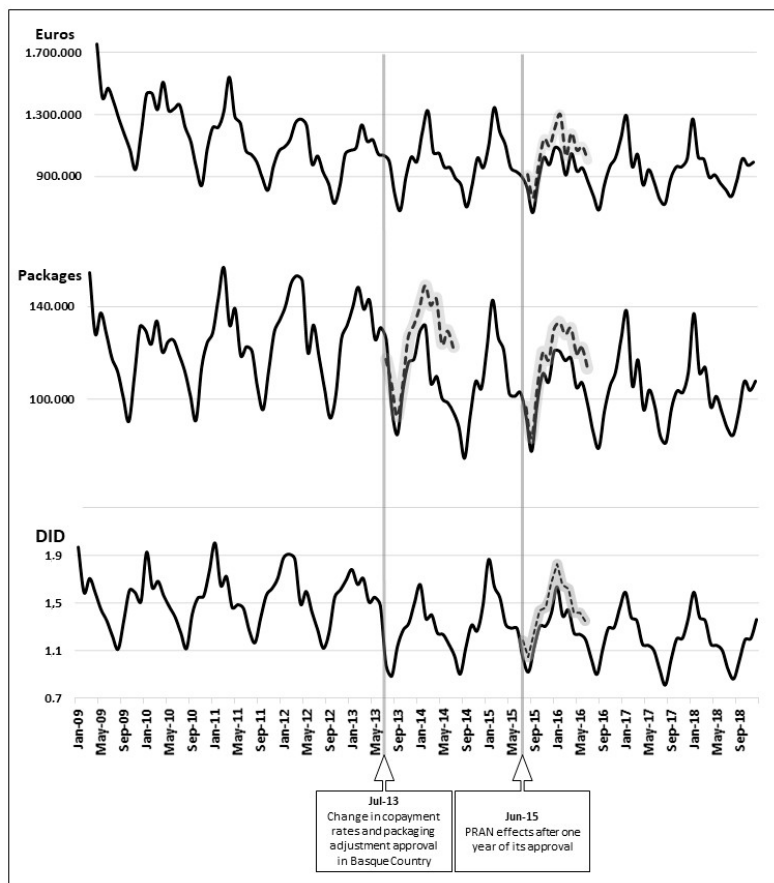
Figure A1. Time series of antibiotic dispensing ( € , packages and DID). Black line: monthly prescription values; dashed line: forecasts (80% confidence interval) obtained in counterfactual analysis. Source: Own elaboration based on data provided by the Basque Government Pharmacy